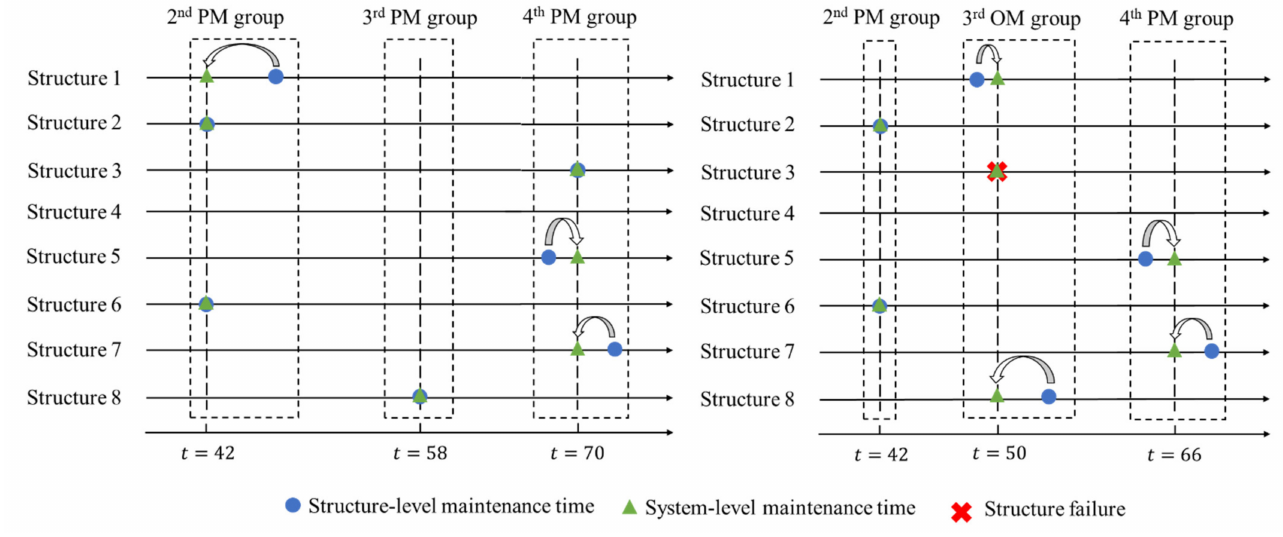
Figure 5. Illustrations of PM grouping ( left ) and PM+OM grouping ( right ). Table 4. Adjusted system-level PM+OM plans under ∆ A control = 0 in 100